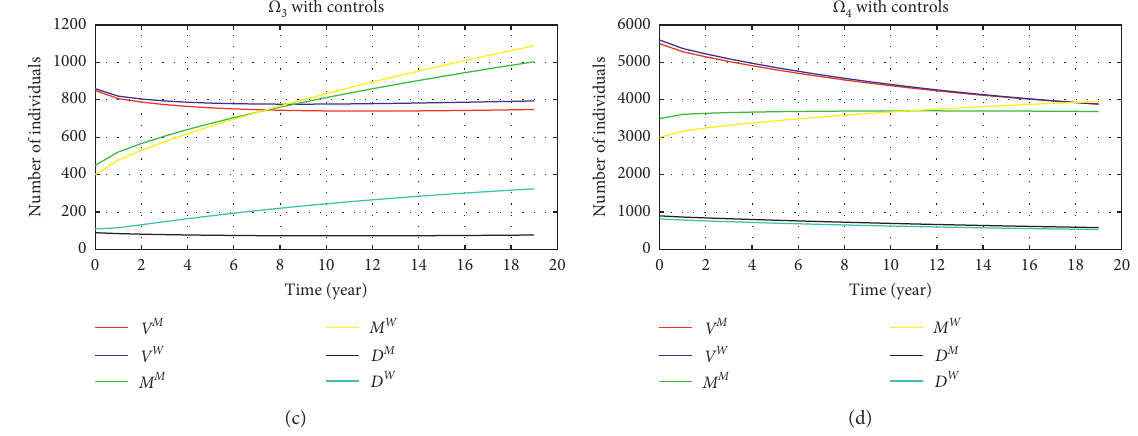
Figure 2: Time evolution of marital status of family dynamics VMDW with controls.